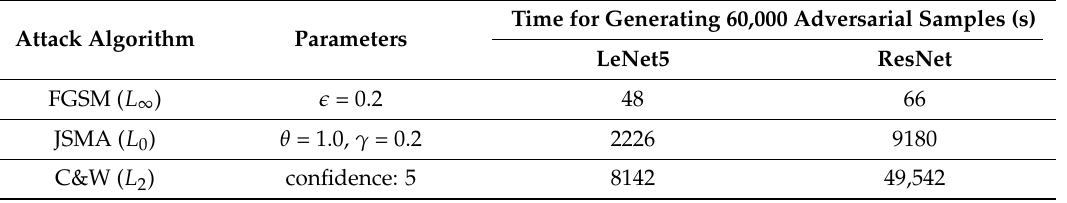
Table 1. Parameters for the attack algorithms and time for generating adversarial examples.